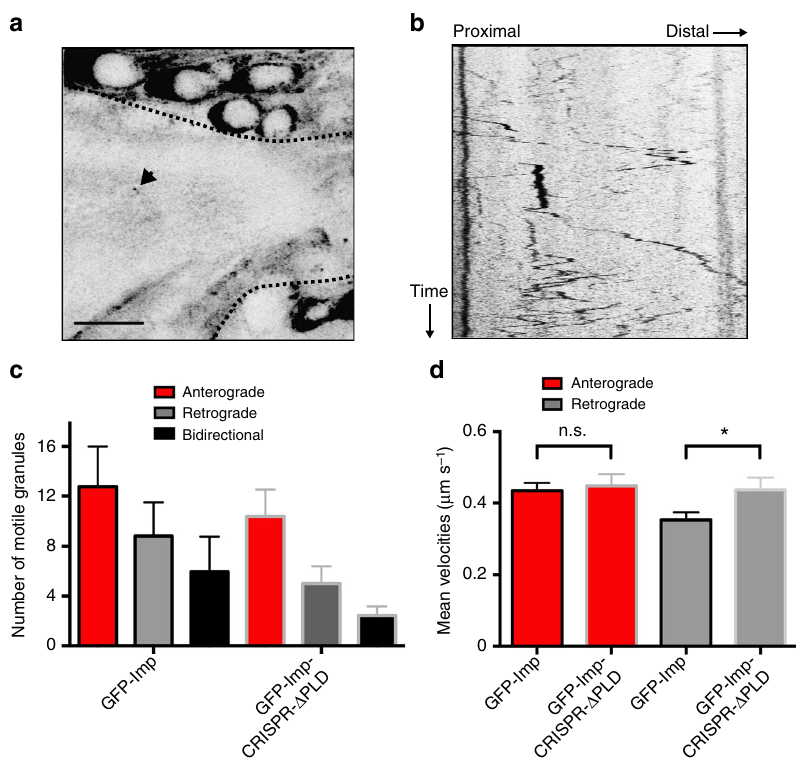
Fig. 6 Imp PLD promotes Imp granule motility. a , b Single image ( a ) and kymograph ( b ) extracted from a video generated from a G080-GFP-Imp hemizygous pupal brain (24 h APF; see also Supplementary Movie 1). The bundle of MB γ axons is delimited by dotted black lines. The arrowhead points to a GFP-Imp granule. Scale bar: 10 μ m. c Average number of motile anterograde, retrograde and bidirectional GFP-Imp granules per 12 min-long movie. Numbers of movies analyzed: n = 17 for G080-GFP-Imp and 16 for GFP-Imp-CRISPR- Δ PLD. Total numbers of granules analyzed: 468 for G080-GFP-Imp and 284 for G080-GFP-Imp-CRISPR- Δ PLD. d Mean anterograde and retrograde velocities. Numbers of anterograde granules analyzed: 271 (G080-GFP- Imp) and 178 (G080-GFP-Imp-CRISPR- Δ PLD); numbers of retrograde granules analyzed: 192 (G080-GFP-Imp) and 91 (G080-GFP-Imp-CRISPR- Δ PLD). Error bars in c , d represent s.e.m. * P < 0.05 (Unpaired t -test). ns stands for not signi fi cant. Source data are provided as a Source Data fi